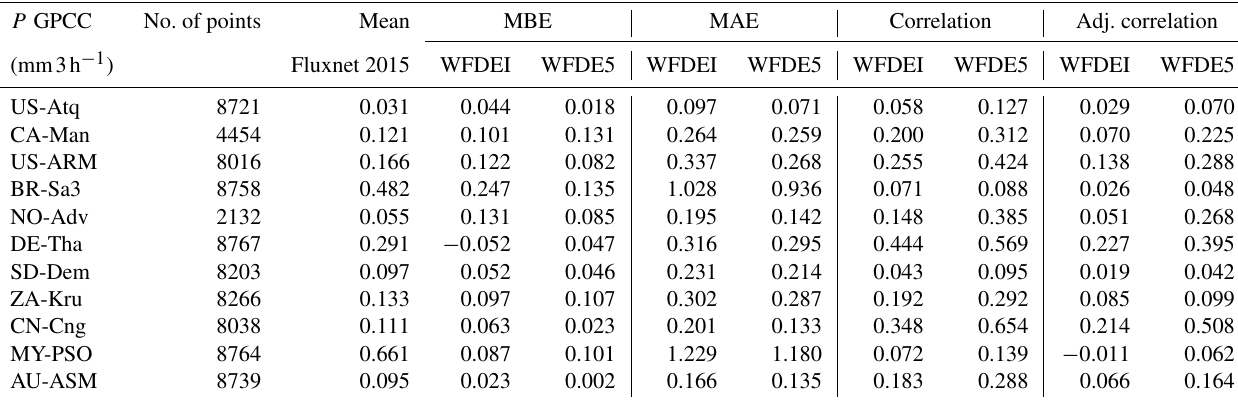
Table A16. Precipitation (Rainf + Snowf) metrics, corrected using GPCC totals, for each FLUXNET2015 site: WFDEI versus FN2015 and WFDE5 versus FN2015 at 3-hourly time